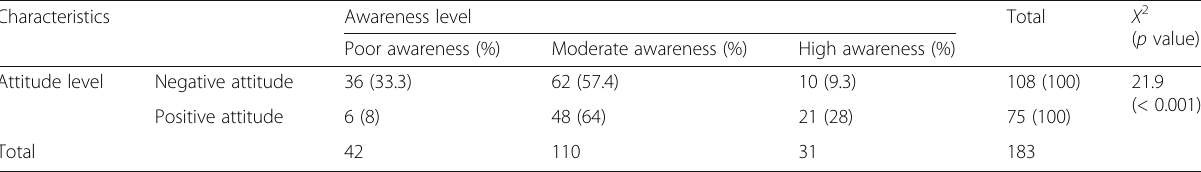
Table 6 Association between the knowledge score and attitude score towards emergency contraception among college students ( n = 183)